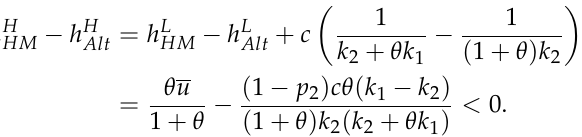
Figure A.2: Optimal contracts for p 2